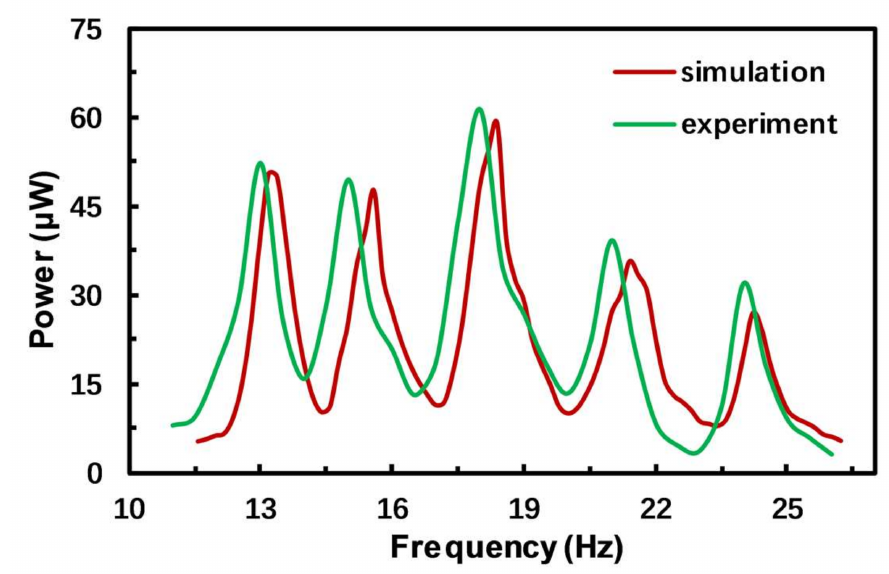
Figure 10. Comparison of simulation and experimental results of frequency